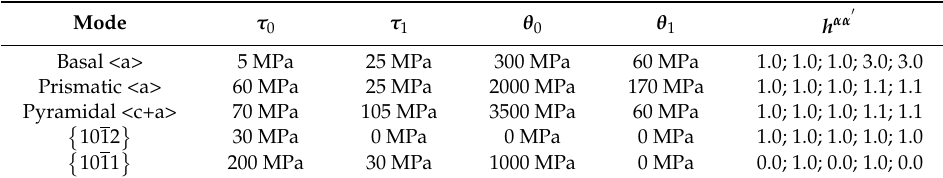
Table 1. Material parameters of AZ31 magnesium alloy used in viscoplastic self-consistent (VPSC) modeling.